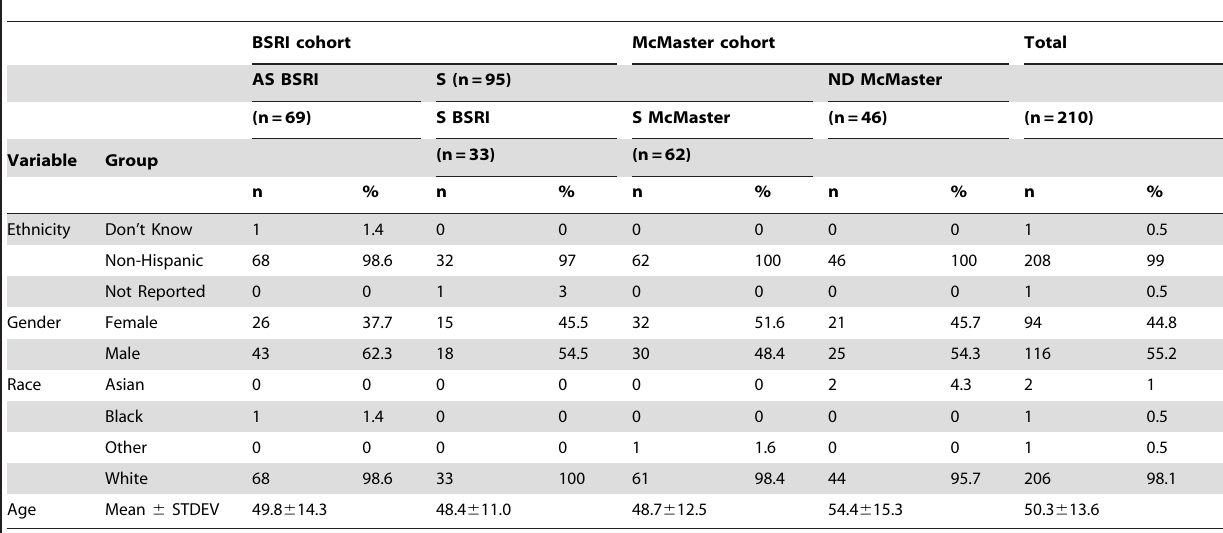
Table 1. Demographics of the BSRI and McMaster